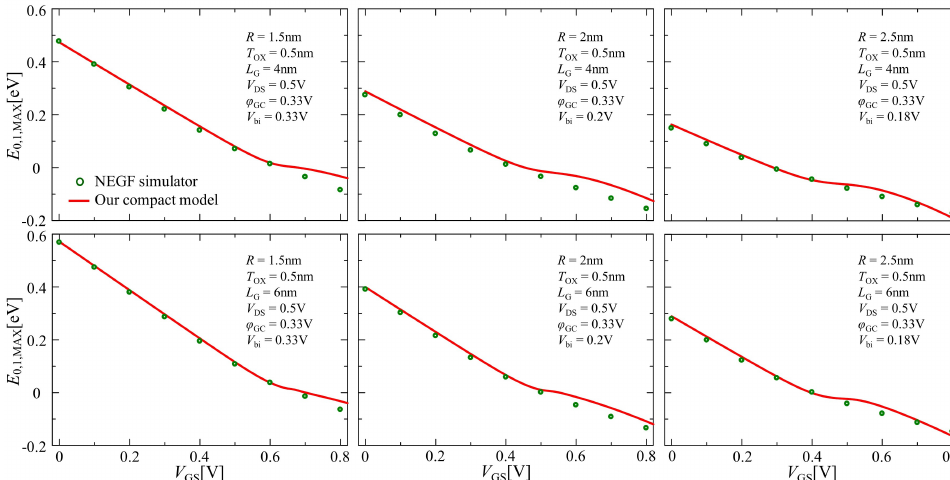
Figure 7. Comparison of the results of the lowest sub-band energy level at the barrier top between NEGF simulation (open circle) and our compact model (solid line) for the lowest sub-band.